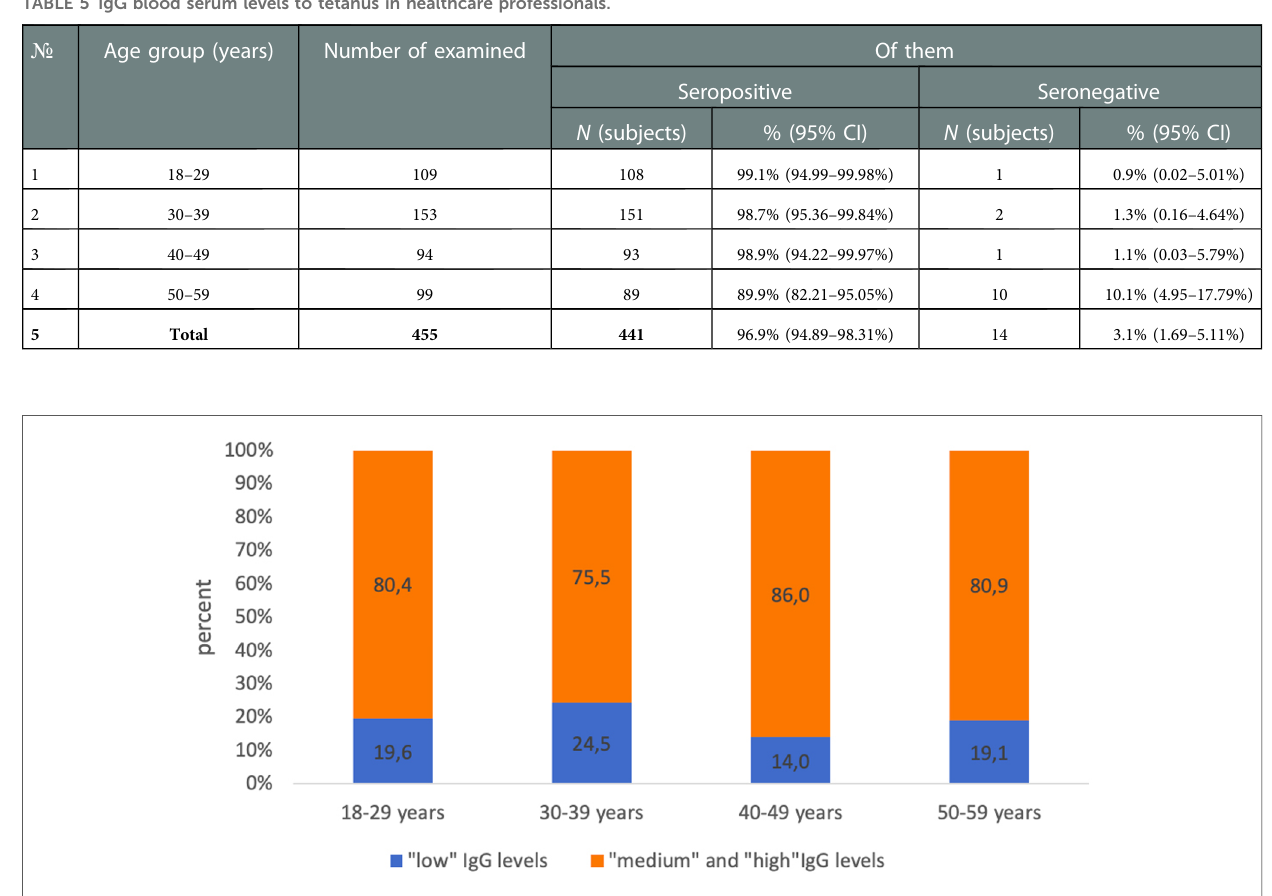
FIGURE 4 Proportion of seropositive healthcare professionals with “ low ” anti-tetanus IgG levels and with “ medium ” and “ high ” anti-tetanus IgG levels in different age